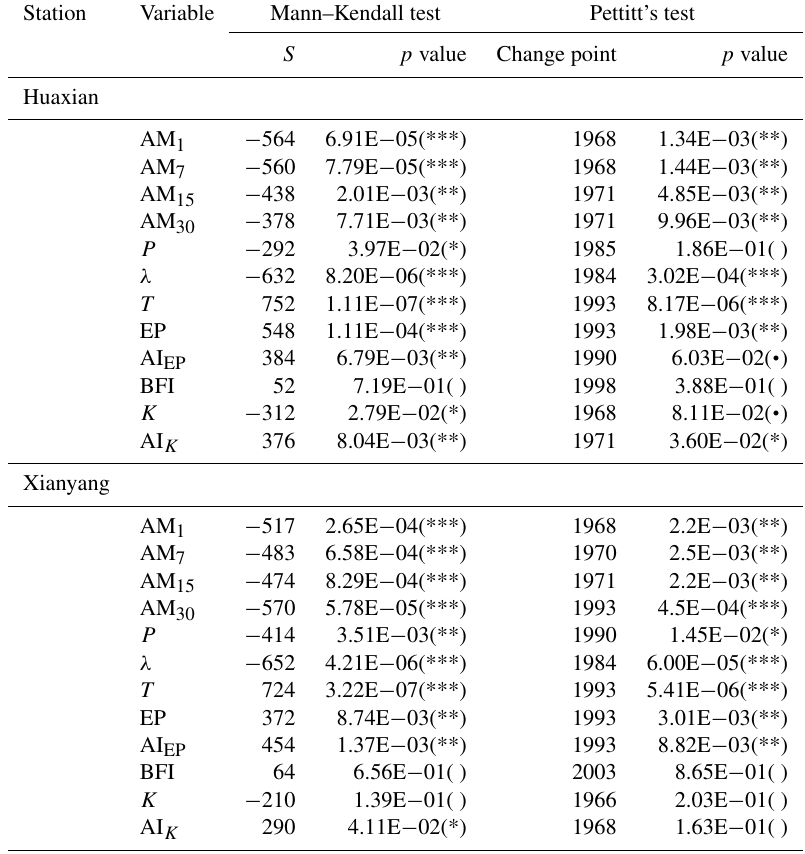
Table 4. The results of trend test and change-point detection for both the four low-flow series and TCCCs variables in Huaxian and Xianyang. Station Variable Mann–Kendall test Pettitt’s test S p value Change point p value Huaxian AM